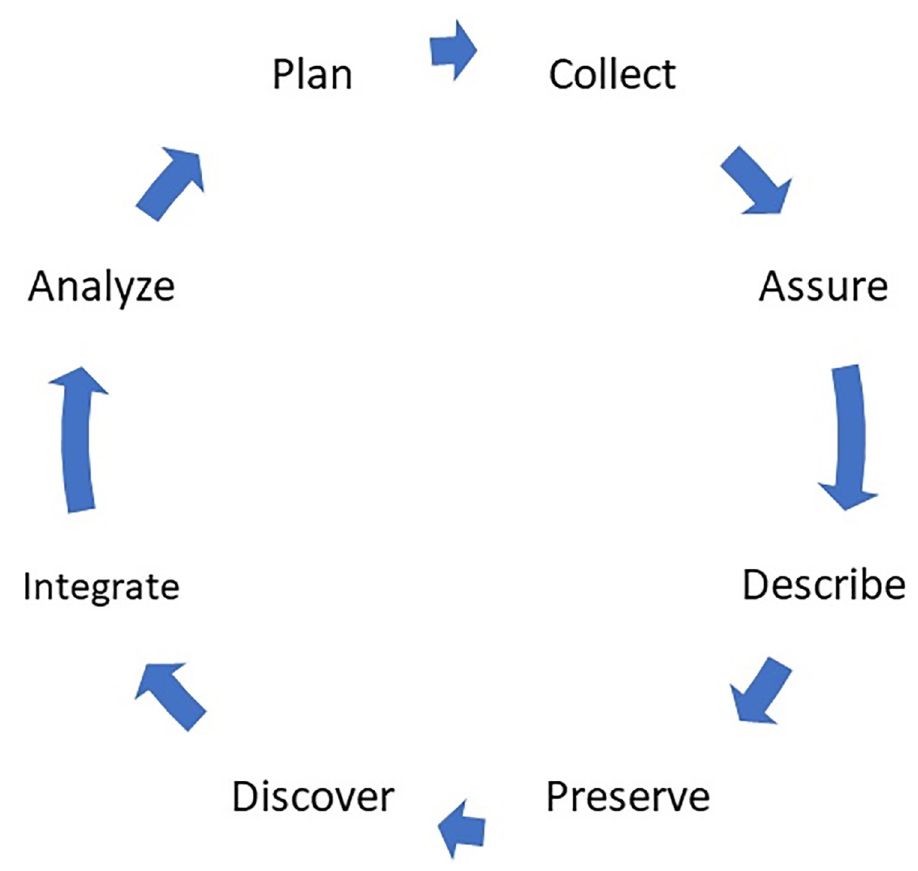
Fig 1. Data life cycle (from https://www.dataone.org/data-life-cycle).